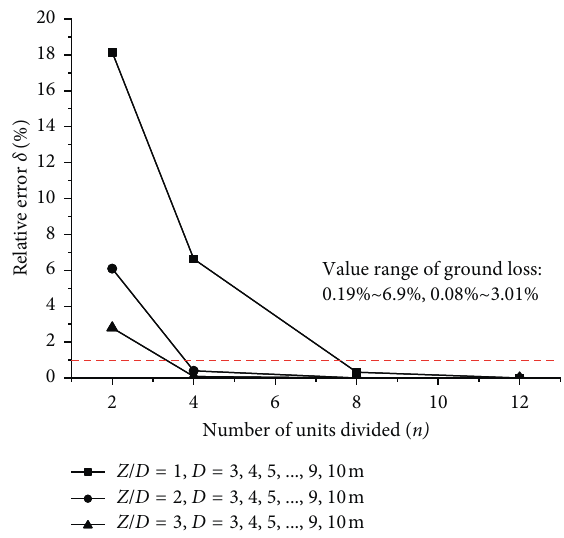
Figure 5: Trend of δ with n .